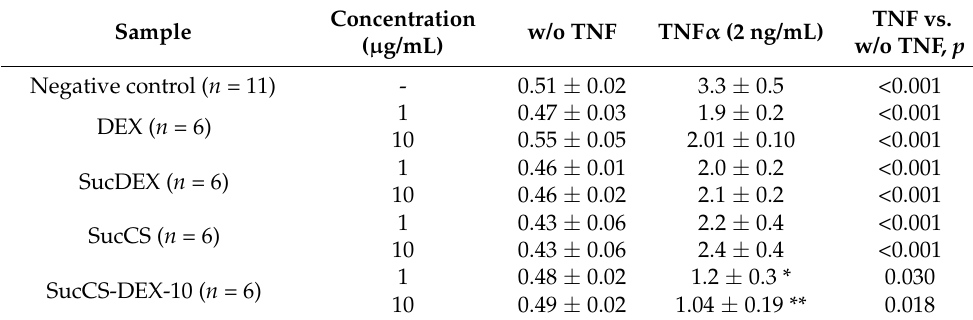
Table 5. The influence of DEX, SucDEX, SucCS, and SucCS-DEX-10 solutions on CD54 expression in THP-1 cells under TNF α -stimulated inflammatory conditions, mean ± SE.